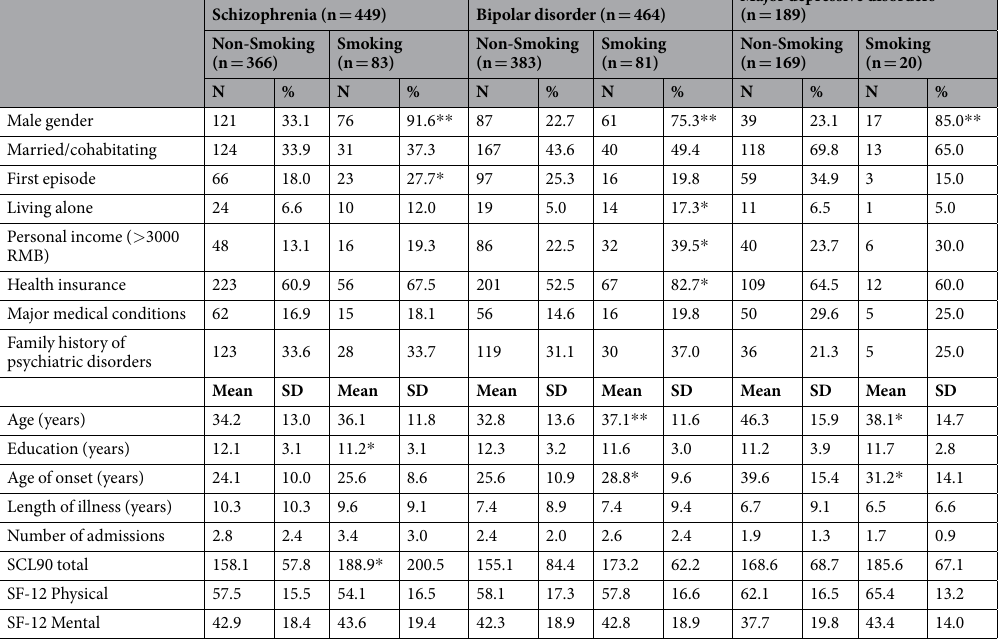
Table 2. Comparisons of demographic and clinical characteristics between smoking and non-smoking groups by diagnoses. * p < 0.05; ** p < 0.01; SCL-90 = Symptom Checklist-90; SF-12 = Medical Outcomes Study Short Form.